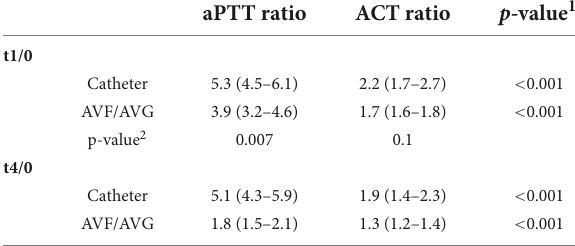
reflecting a larger increase of aPTT relative to ACT with incremental anticoagulation.